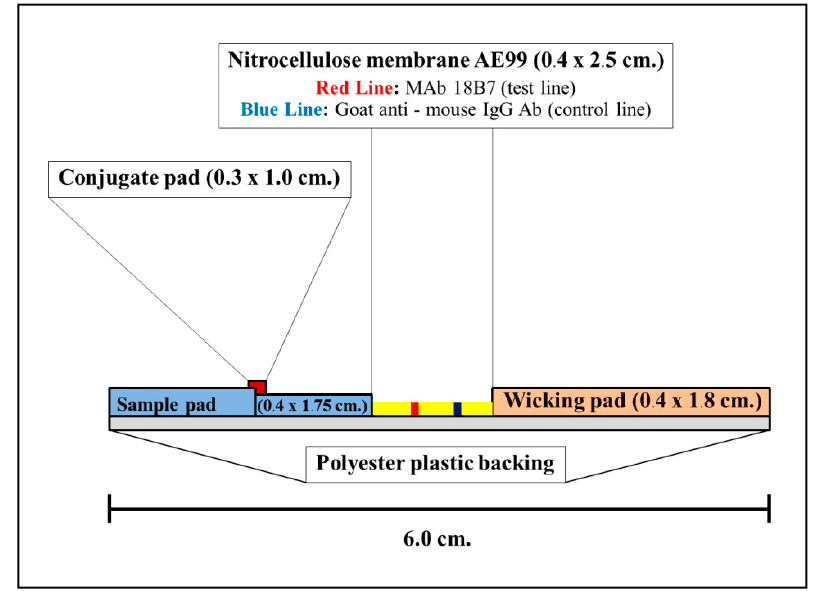
Figure 3. A side view of the mAb 18B7 sandwich ICT strip.